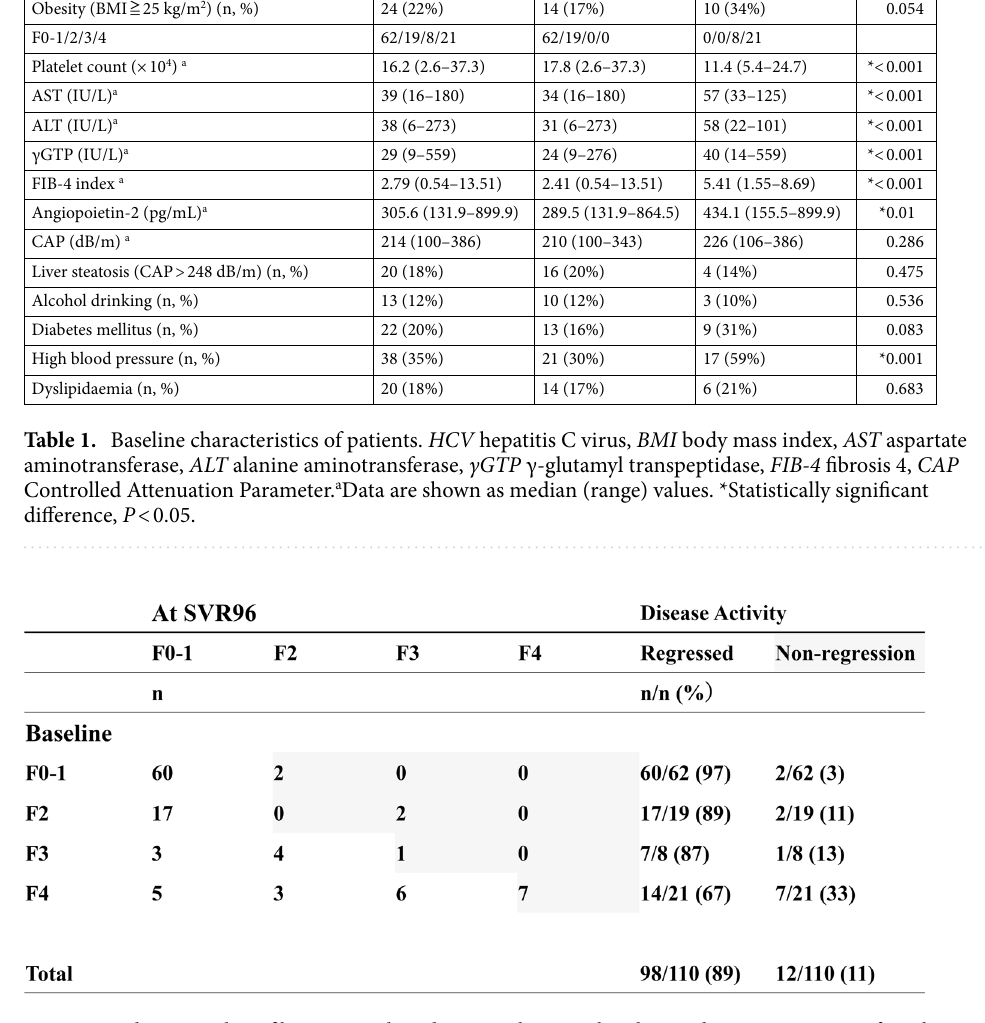
Figure 1. Changes in liver fibrosis stage based on LSM between baseline and SVR96 in HCV-infected patients treated with DAAs. LSM liver stiffness measurement, SVR sustained virological response, DAAs direct-acting antivirals. The grey area represents regression of liver fibrosis after DAAs